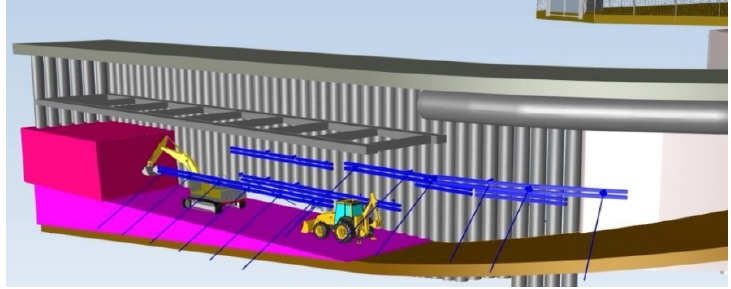
Figure 1. Example of visualization of construction stage in underground works.